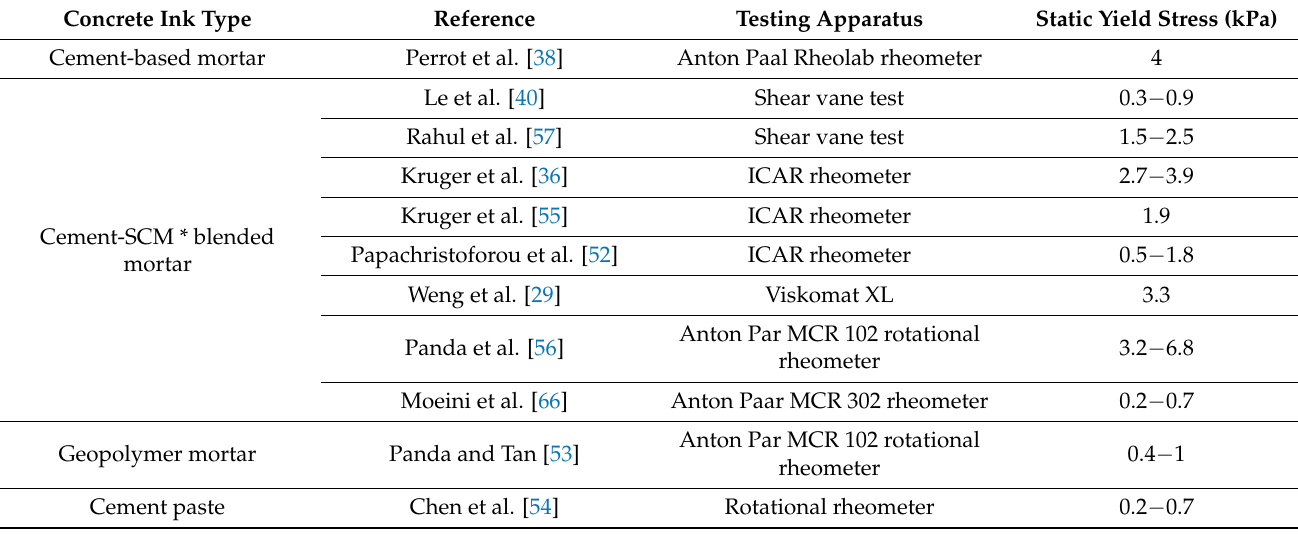
Table 1. Static yield stress values reported in literature for different printable concrete